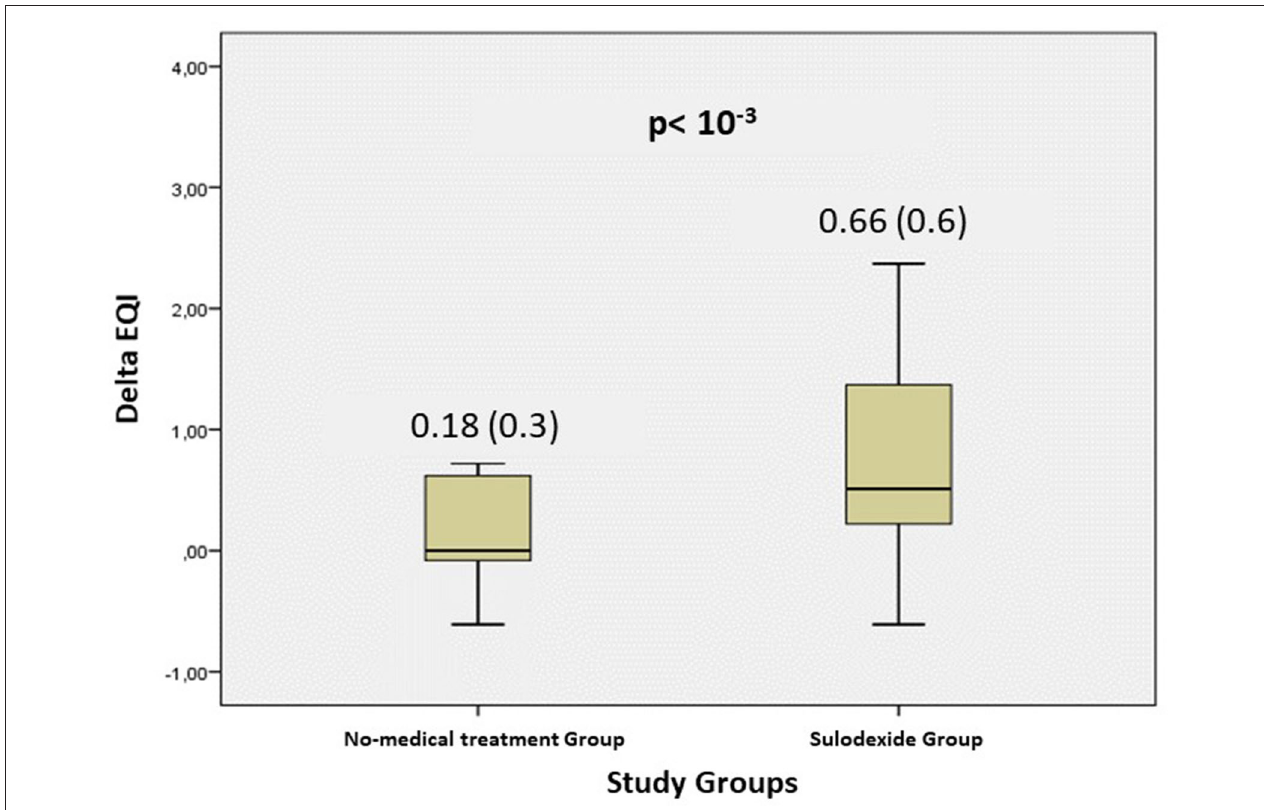
FIGURE 2 | Evolution of the endothelium quality index (delta EQI) at 21-days follow-up in the 2 study groups.